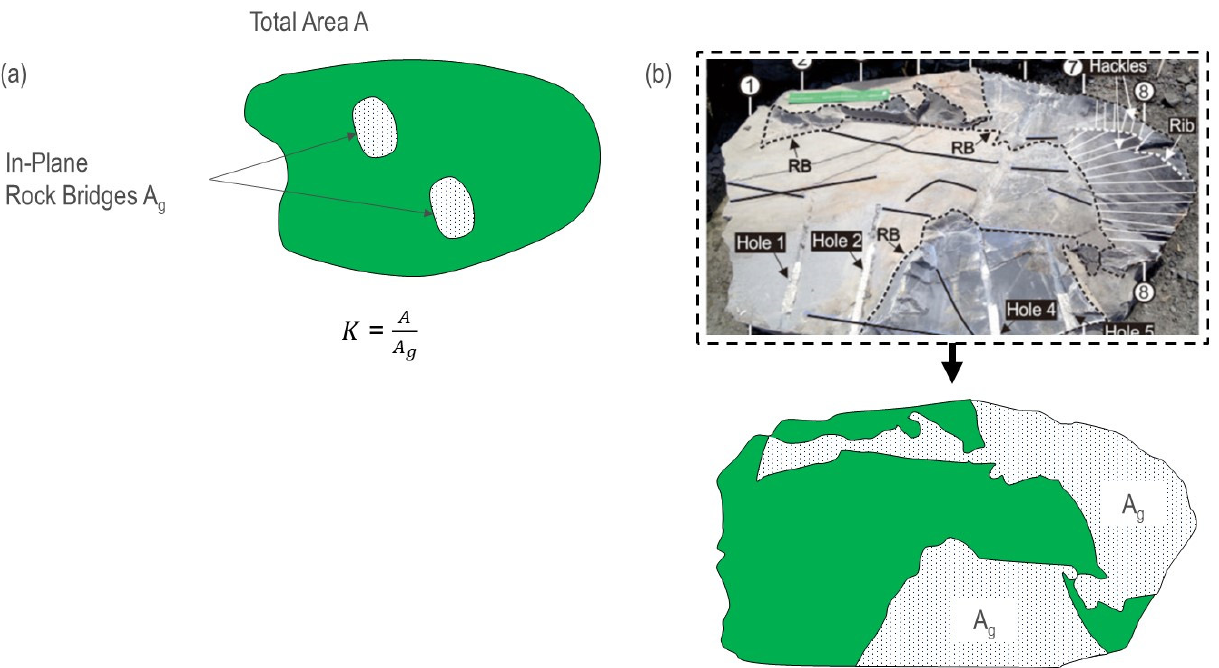
Figure 1. ( a ) Definition of rock bridge by [2], and ( b ) interpretation of rock bridges using an image from [4].